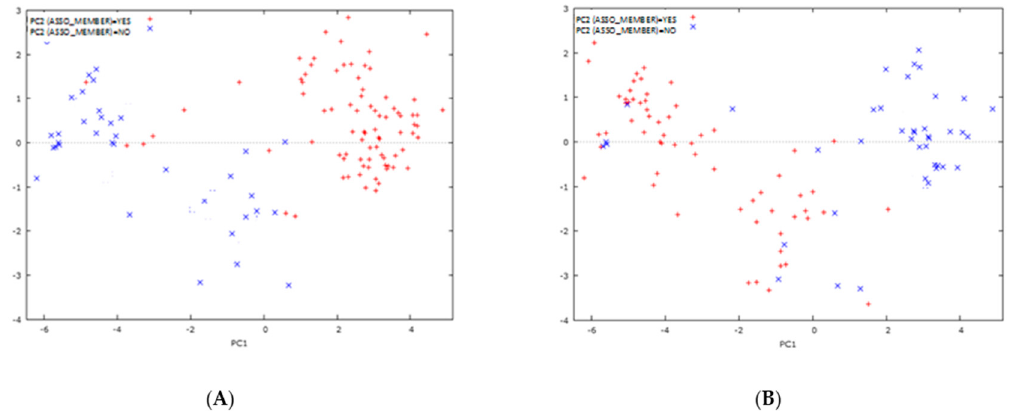
Figure 7. ( A ) Scatter plot of Arriba producers and associativity; ( B ) Scatter plot of CCN-51 producers Figure 7. (A) Scatter plot of Arriba producers and associativity; (B) Scatter plot of CCN-51 producers and and associativity.